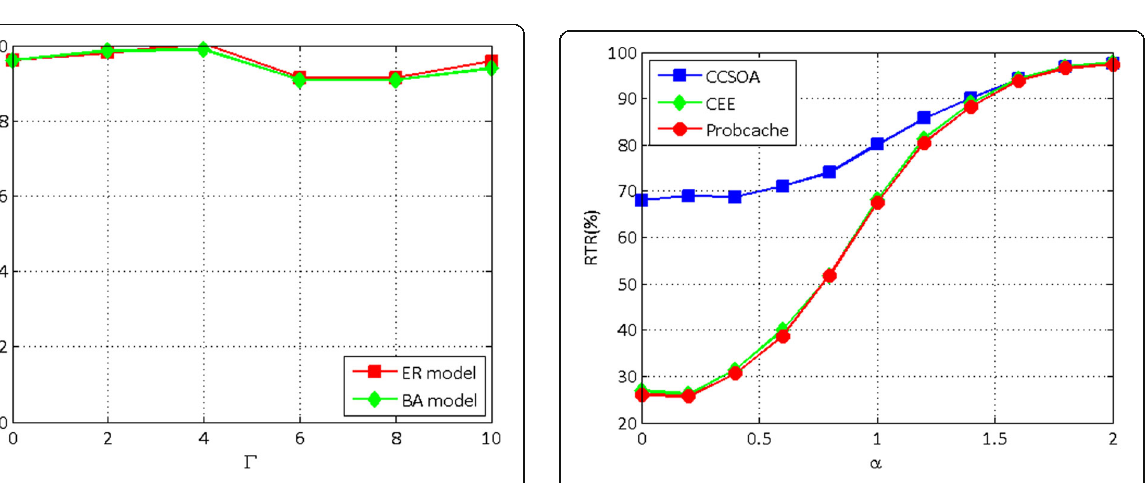
Fig. 32 The impact of T SBS